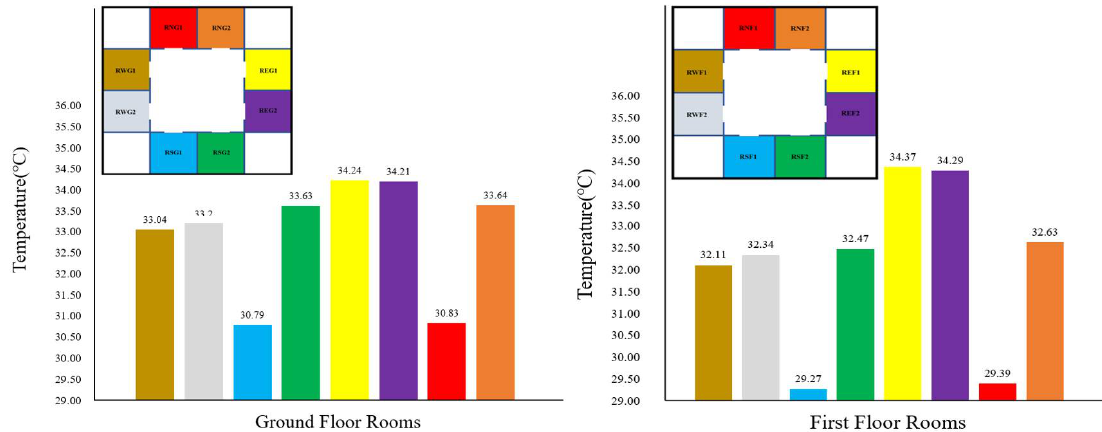
Figure 23. Average air temperature ( ◦ C) in each room for the baseline courtyard model with four large trees.